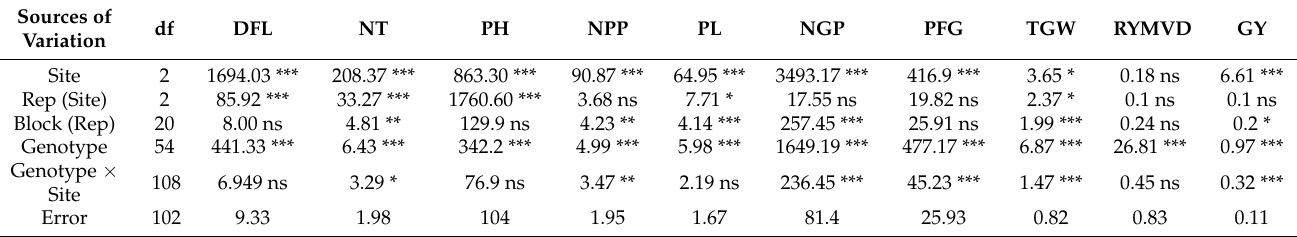
Table 4. Mean squares and significant tests for 10 traits among 10 parents and 45 F2 crosses of rice evaluated in three locations in